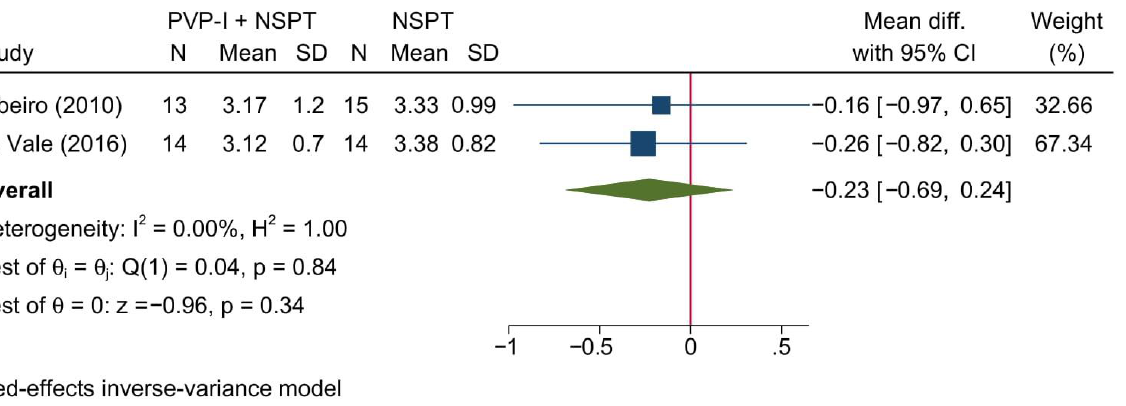
Figure 9. Forest plot showing the comparison between PVP-I + NSPT and NSPT alone regarding the position of gingival margin [40,46].